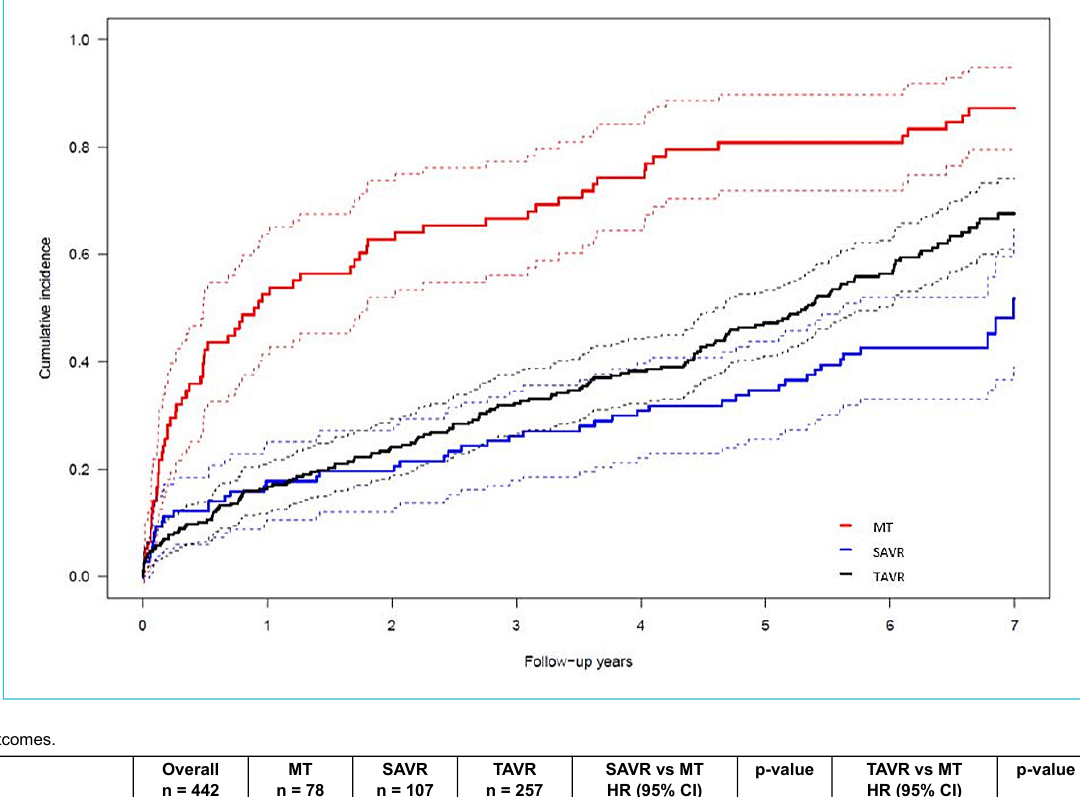
Figure 1: Cumulative incidence curves of all-cause death. The competing risk model shows patients allocated to MT (red), TAVR (black), and SAVR (blue). SAVR vs MT: p <0.0001; TAVI vs MT: p <0.0001. Confidence intervals are depicted as dashed lines.